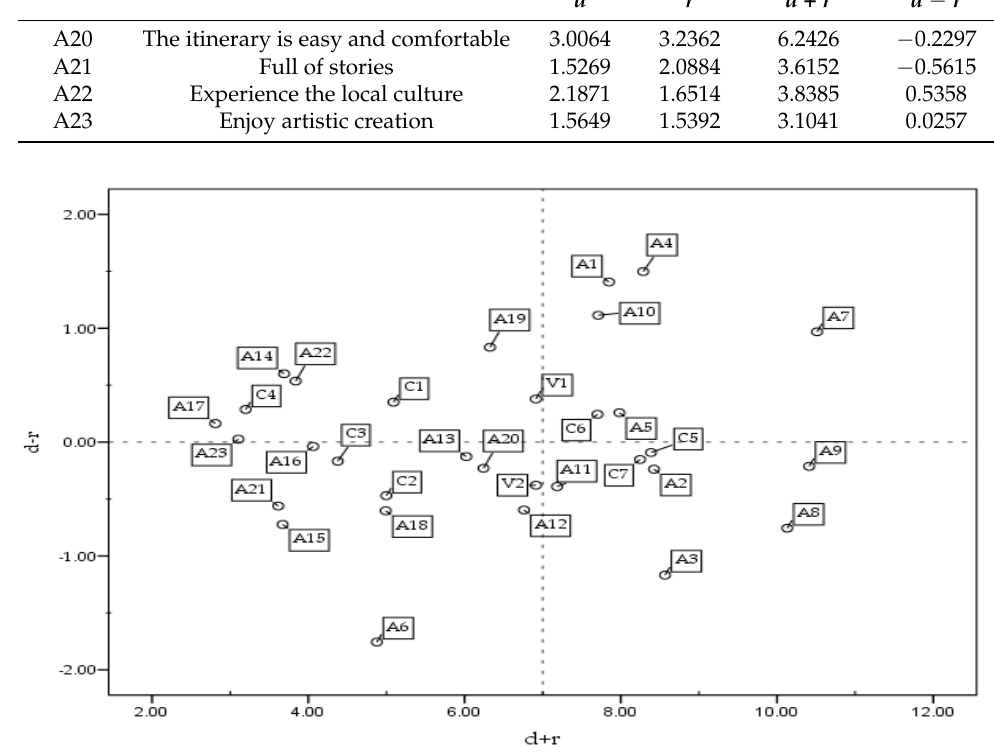
Figure 2. Coordinate of centrality and cause of each index.